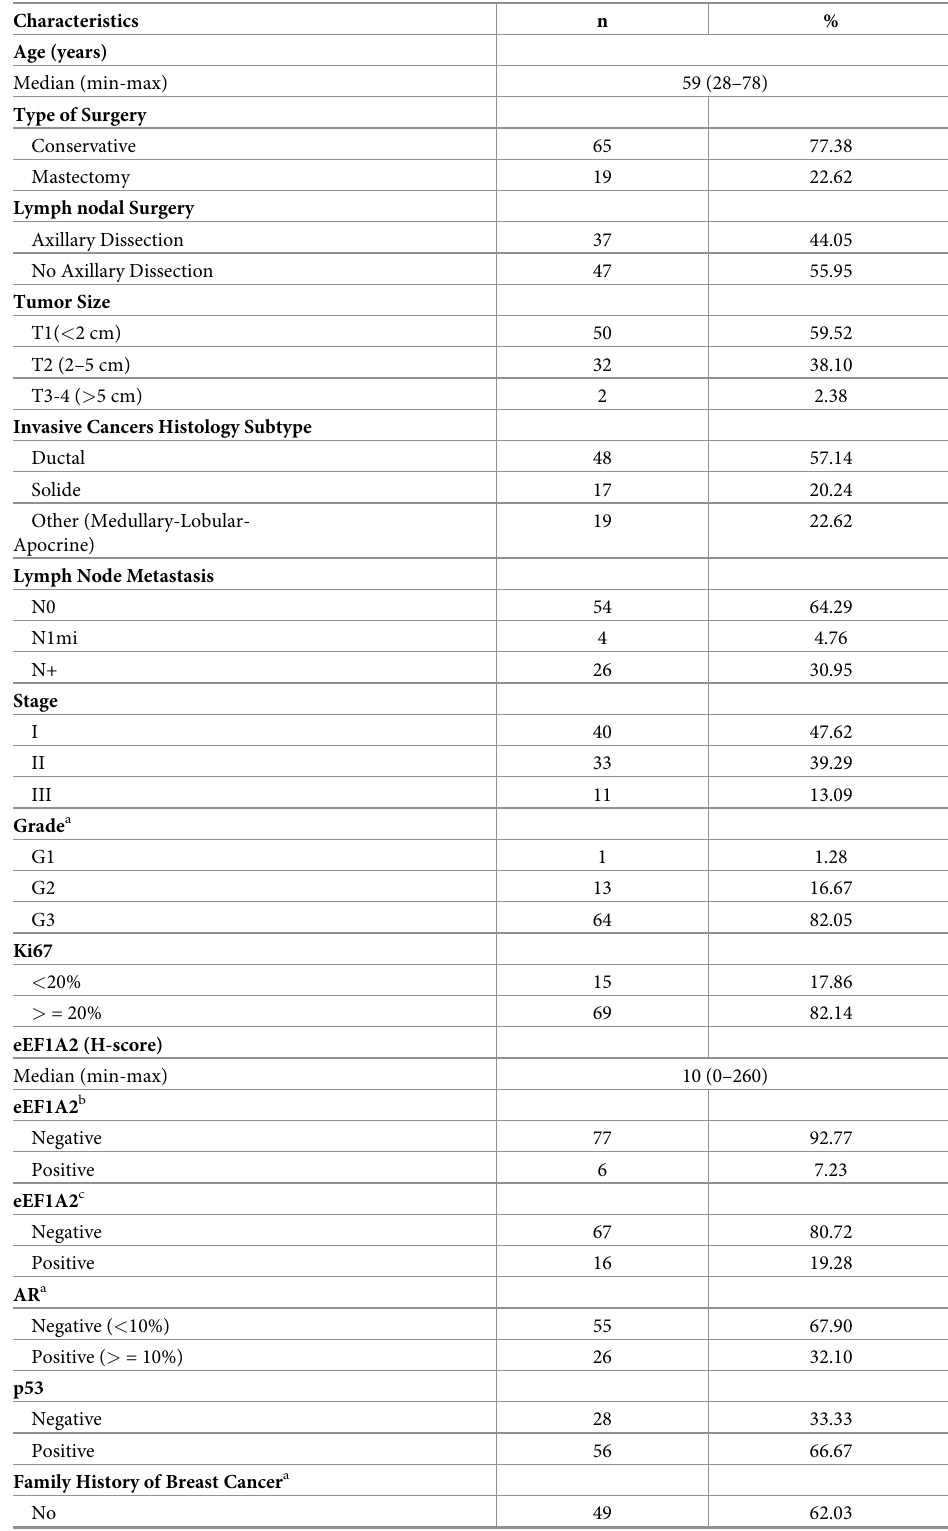
Table 1. Patients characteristics (n =